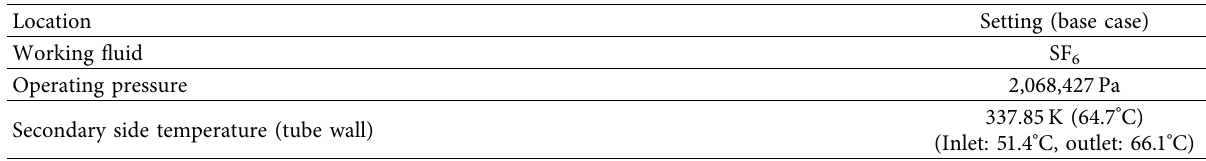
Table 1: Analysis